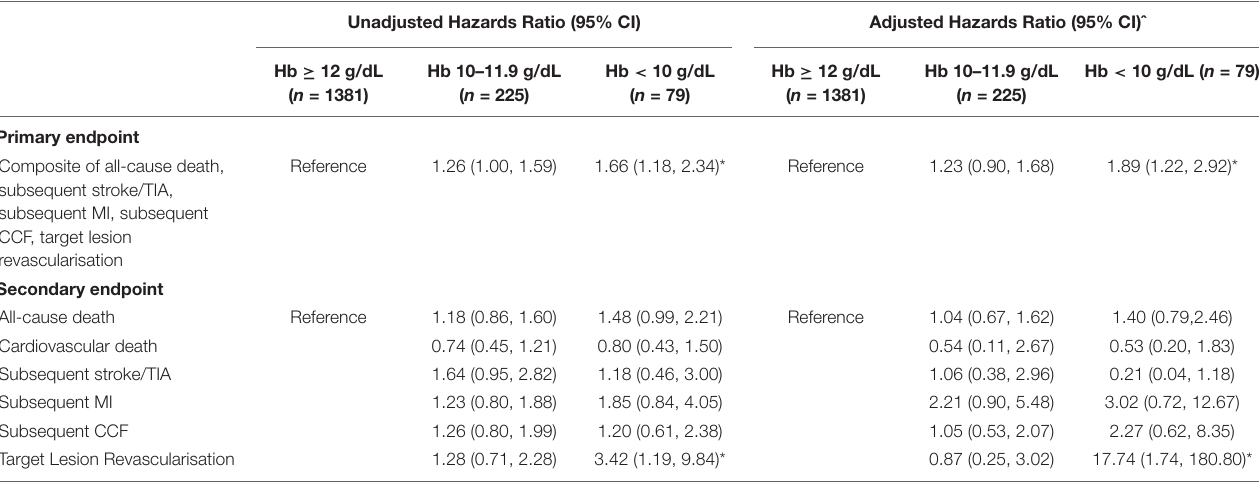
FIGURE 2 | (A–G) Kaplan–Meier Curves show the primary outcomes of 5-point MACCE and secondary endpoints of all-cause mortality, cardiovascular mortality, subsequent stroke/TIA, subsequent MI, subsequent CCF, and target lesion revascularisation. CCF, congestive cardiac failure; TIA, transient ischaemic attack; MI, myocardial infarction; Hb, haemoglobin; MACCE, major adverse cardiac and cerebrovascular events. TABLE 2 | Unadjusted and adjusted hazard ratios of primary and secondary